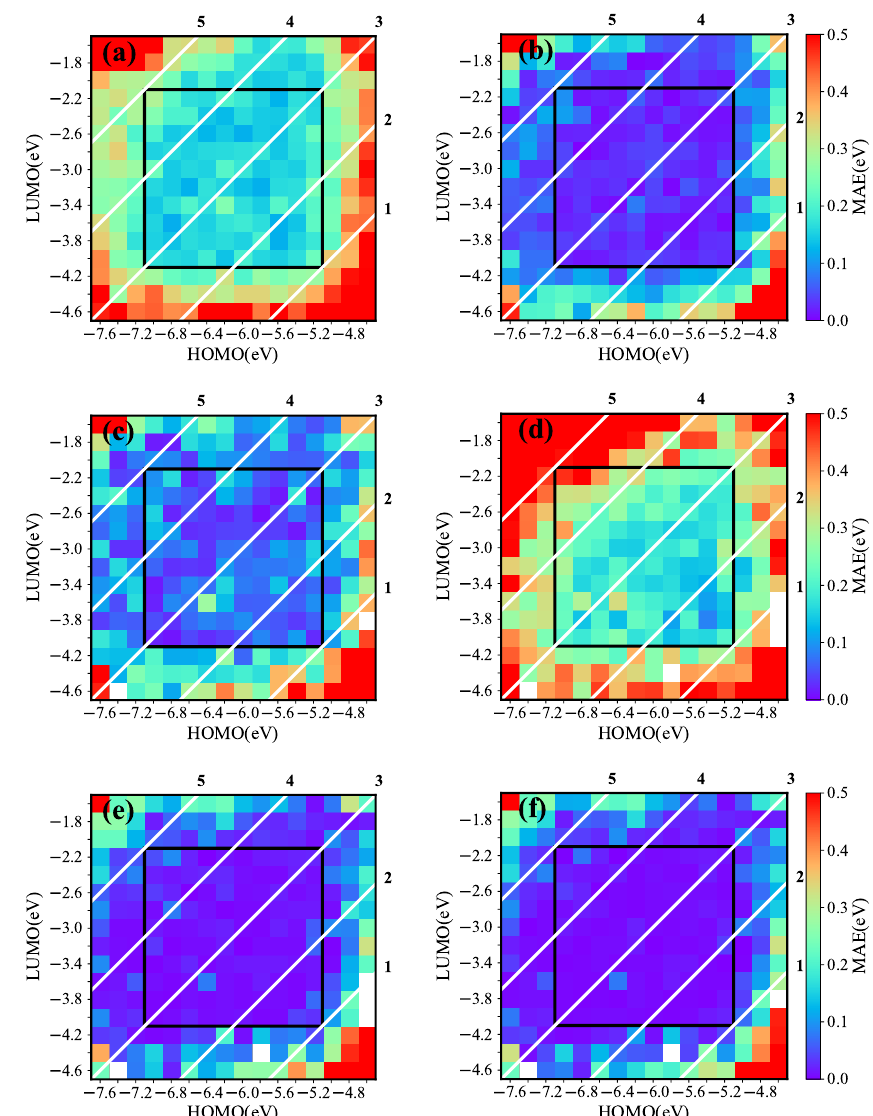
Figure 5. The performance of the conditional generative model for the desired HOMO/LUMO energies in a broad range. The heatmap shows the MAEs of predicted properties and targeted values for generated molecules (the white diagonals are the constant bandgap of the HOMO and LUMO). ( a ) The MAEs of molecules generated in 30 runs for desired HOMO/LUMO energies (unreasonable molecules are excluded). ( b ) The MAEs of the best matched molecules screened out in 30 runs. ( c ) The MAEs of the best matched new molecules in 30 runs. ( d ) The MAEs of all possible molecules transformed from molecules in ( c ) with the transformation rule database created by the original library. ( e ) The MAEs of the best matched new molecules in the transformed molecules. ( f ) The MAEs of the best matched new molecules transformed from molecules in ( c ) with the rule database created by the original library and our